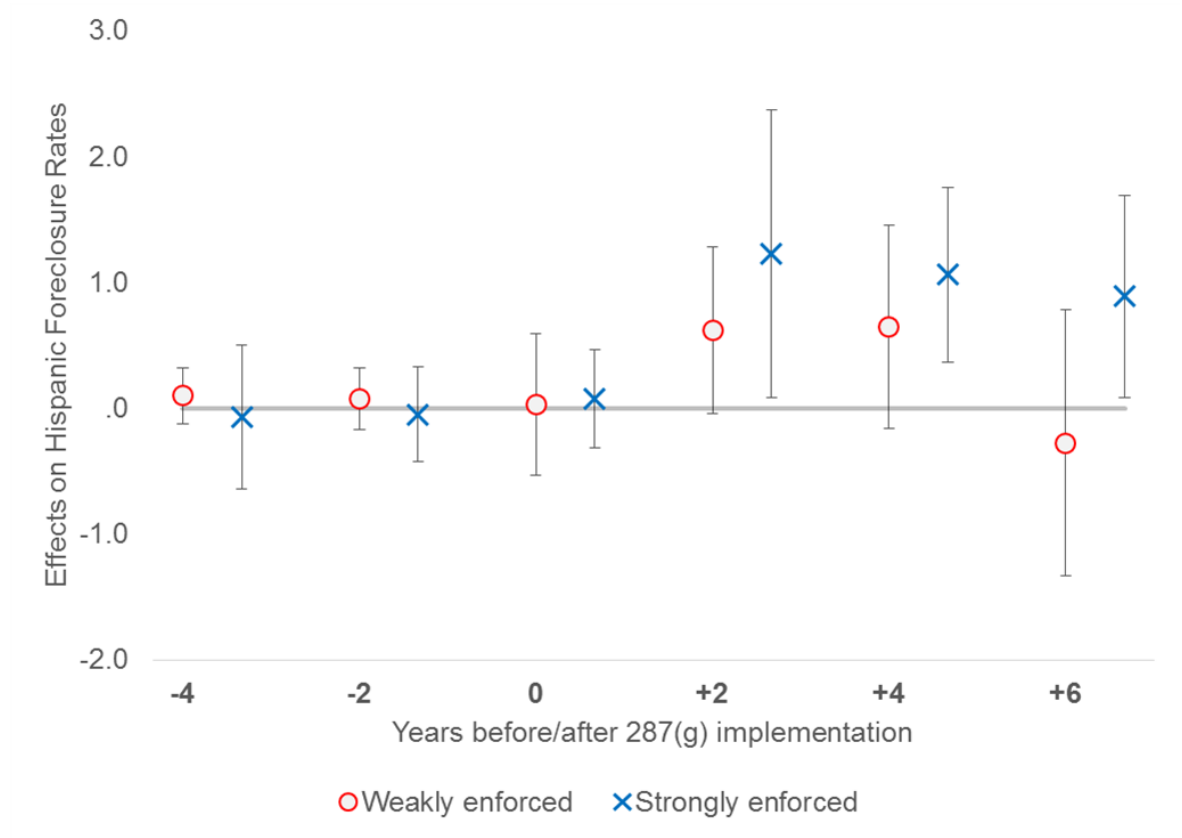
Figure 4: Effects of 287(g) on Hispanic foreclosure rates, by enforcement